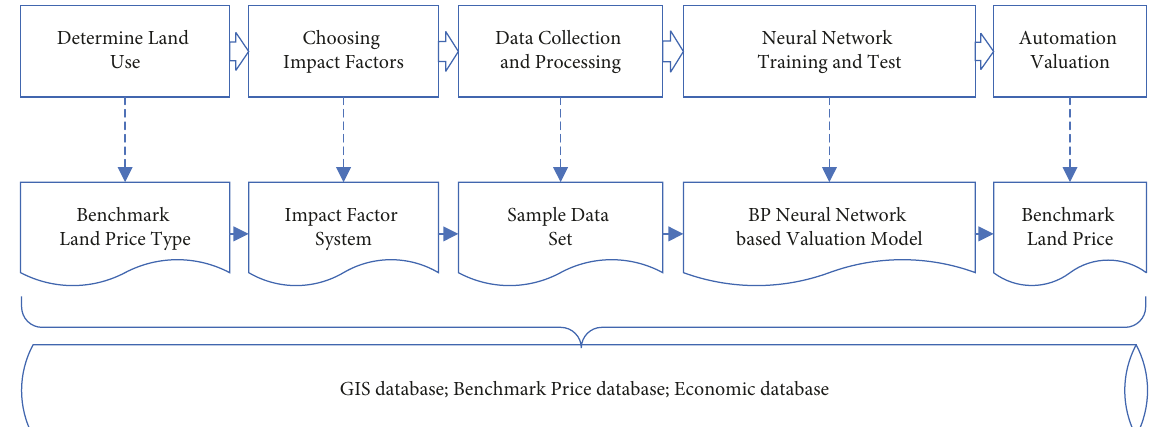
Figure 1: Basic procedure of the automated valuation